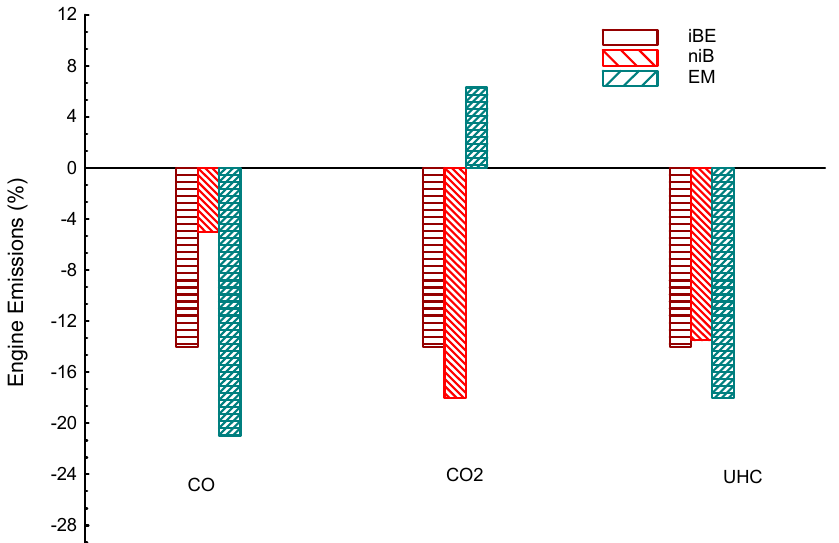
Figure 4. Comparisons of CO, CO 2 , and UHC emissions for ethanol–methanol (EM), n-butanol– i-butanol (niB) and ethanol–i-butanol (iBE) blended with gasoline and neat gasoline (baseline) in %.